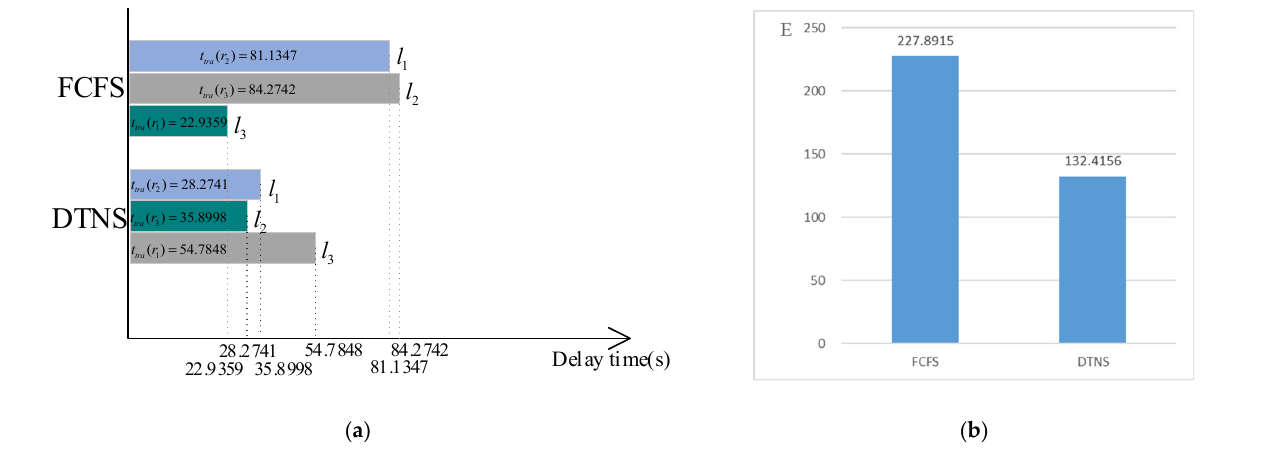
Figure 10. Comparison of efficiency under the condition of three robot-trailer in scenario 1. ( a ) Com- parison of towing service time. ( b ) Comparison of delay expectations.